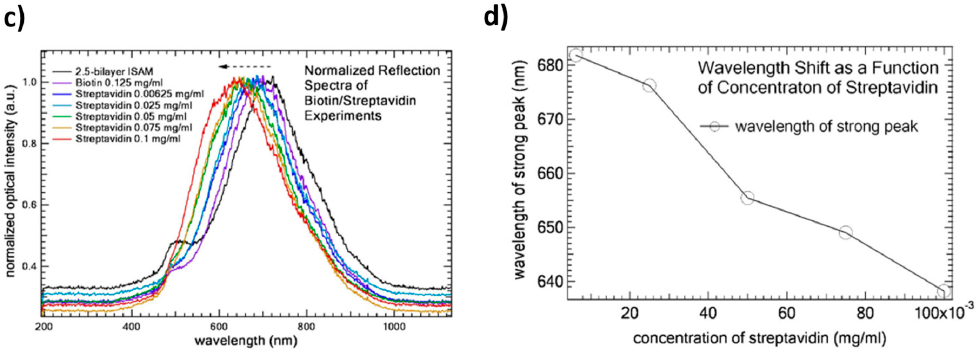
Figure 16. ( a ) Schematic representation of the optical setup and the fabrication of the thin film onto the end-face of the fiber; ( b ) SEM picture of the cross-section of a cleaved optical fiber coated by 10-bilayers; ( c ) normalized reflection spectra measured in air as a function of the concentration of streptavidin; ( d ) wavelength shift of the LSPR peak as a function of streptavidin concentration. Reproduced from [139] with permission from Wan et al. (2010).